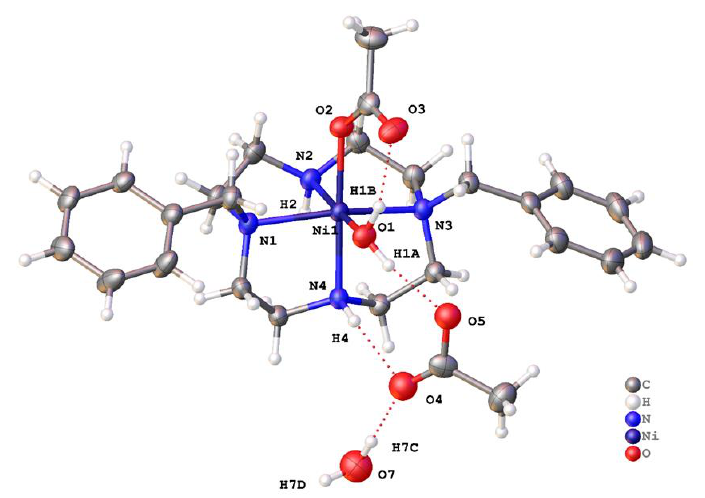
Figure 6. Asymmetric unit of [Ni( 1 )(OOCCH 3 )(OH 2 )](OOCCH 3 ) · H 2 O with atoms drawn as 50% probability ellipsoids. Dashed lines show classical hydrogen bonds.